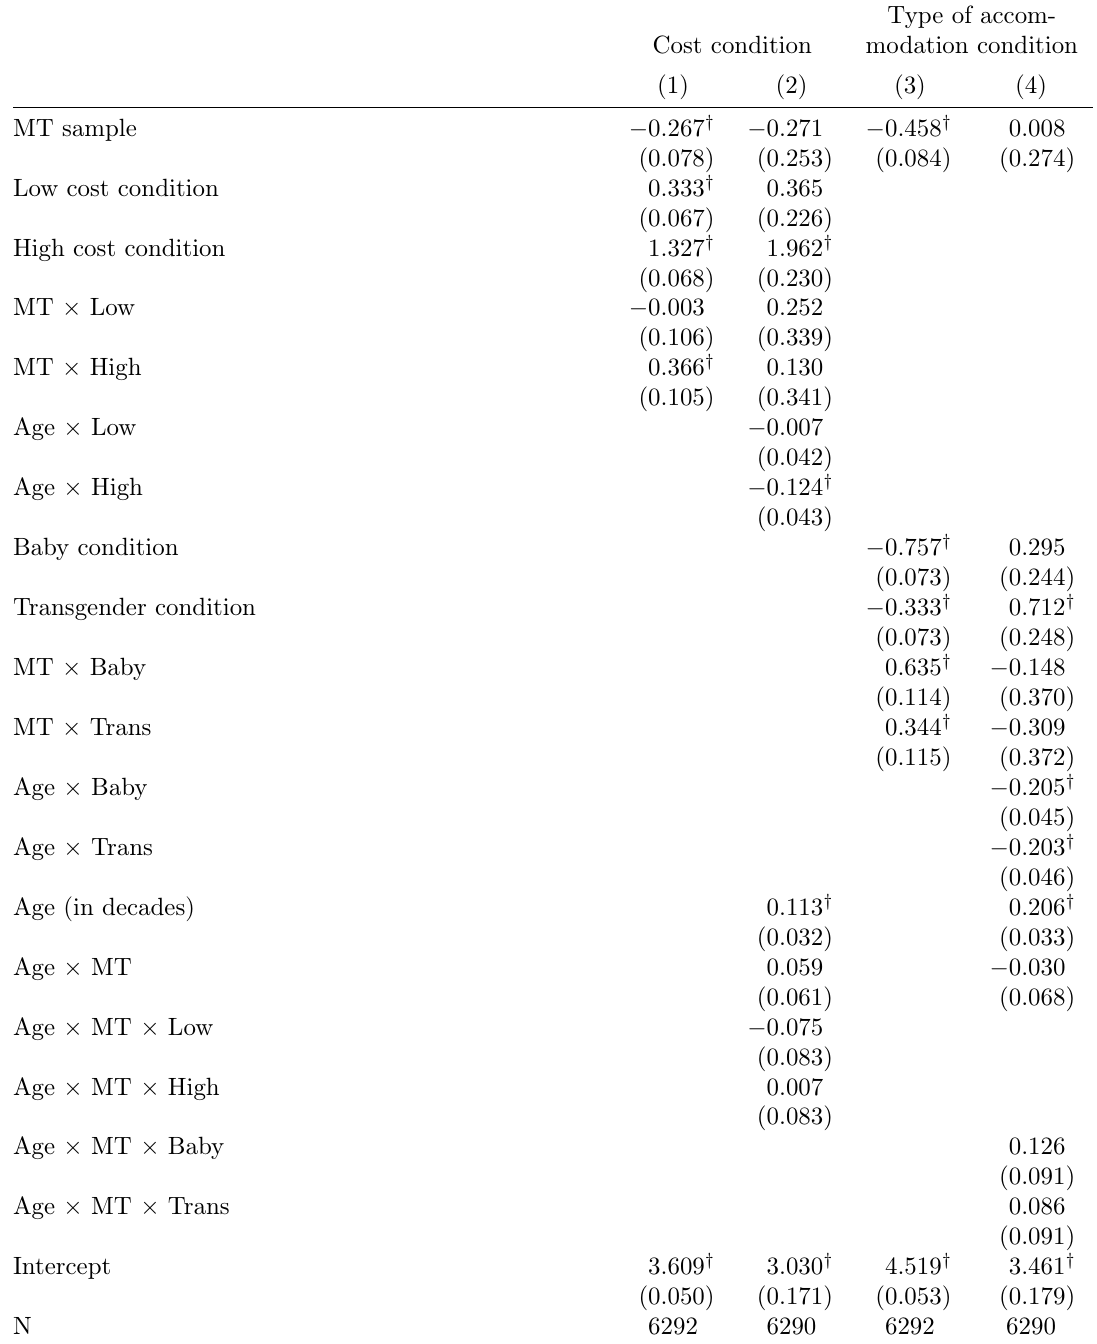
Table 4: Hierarchical random-effects OLS models of the interaction of experimental conditions by sample type and age for reasonable accommodation vignette